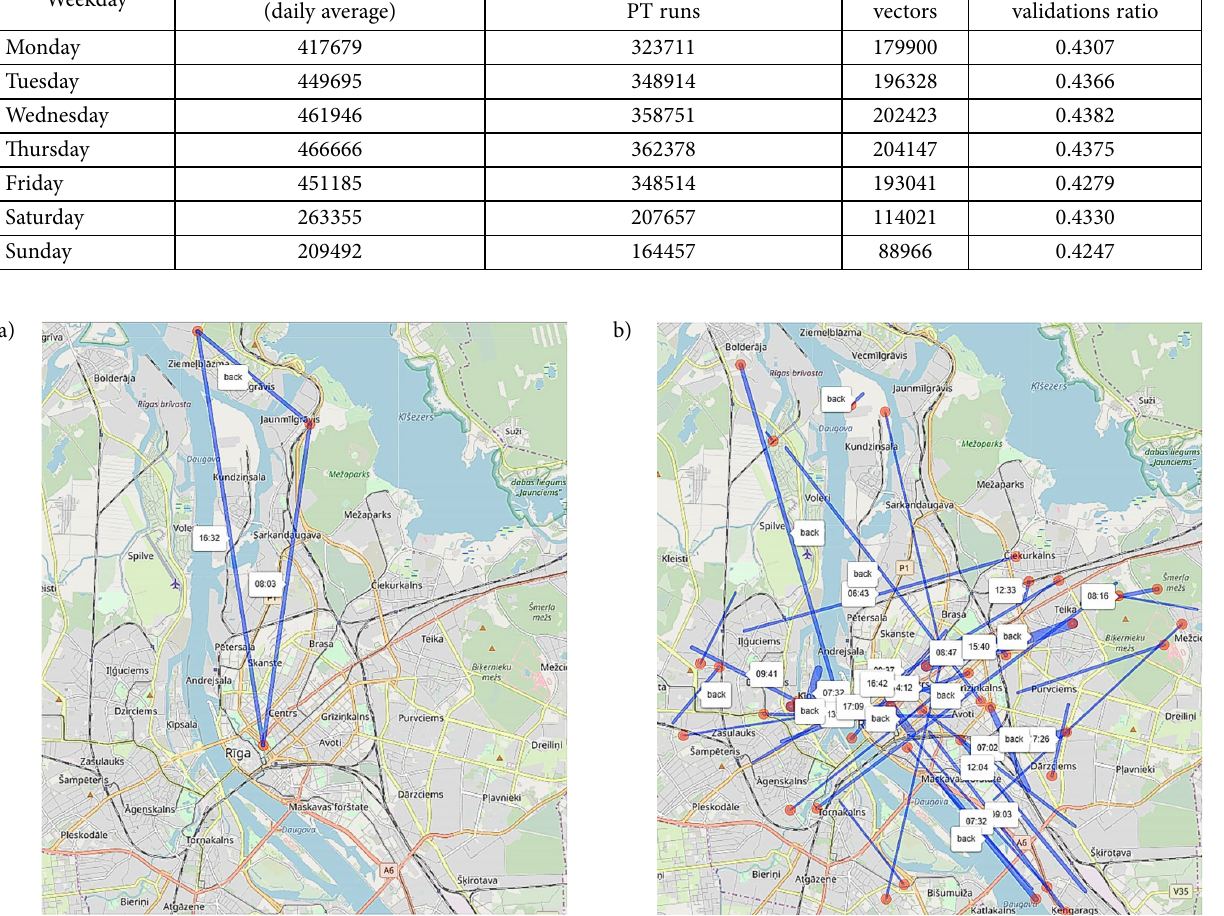
Figure 6. Typical individual trip vectors (a) and a daily mobility pattern (b) – destinations are marked with red circles; flow volumes presented by